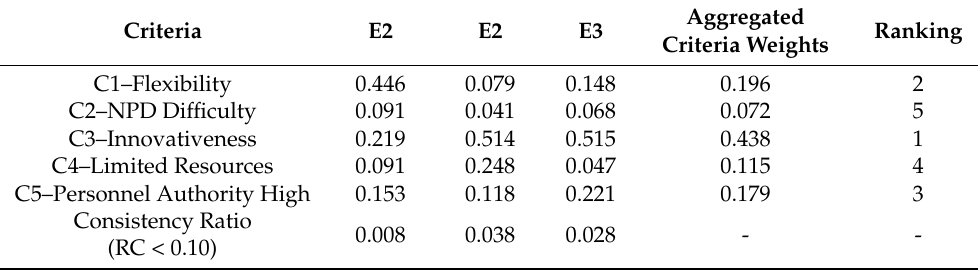
Table 5. Criteria weights (AHP method) from Japanese experts